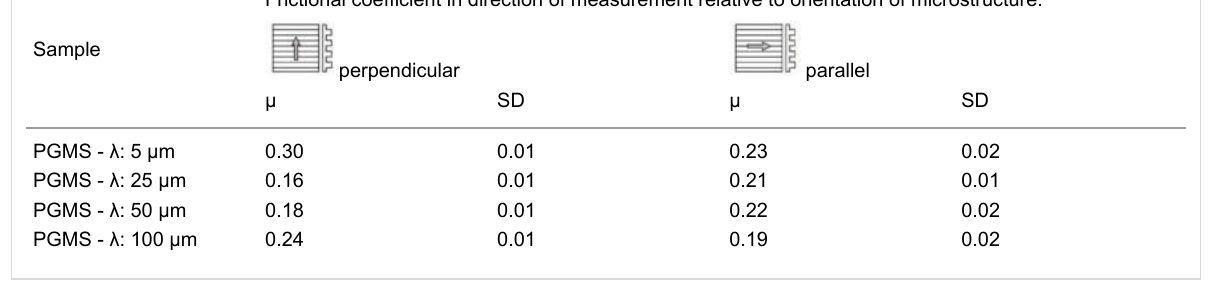
Table 2: Mean frictional coefficients (µ) of periodical groove-like polymer surface – PGMS determined by the zero-frequency of the FFTs and stan- dard deviation (SD). λ : pitch dimension.